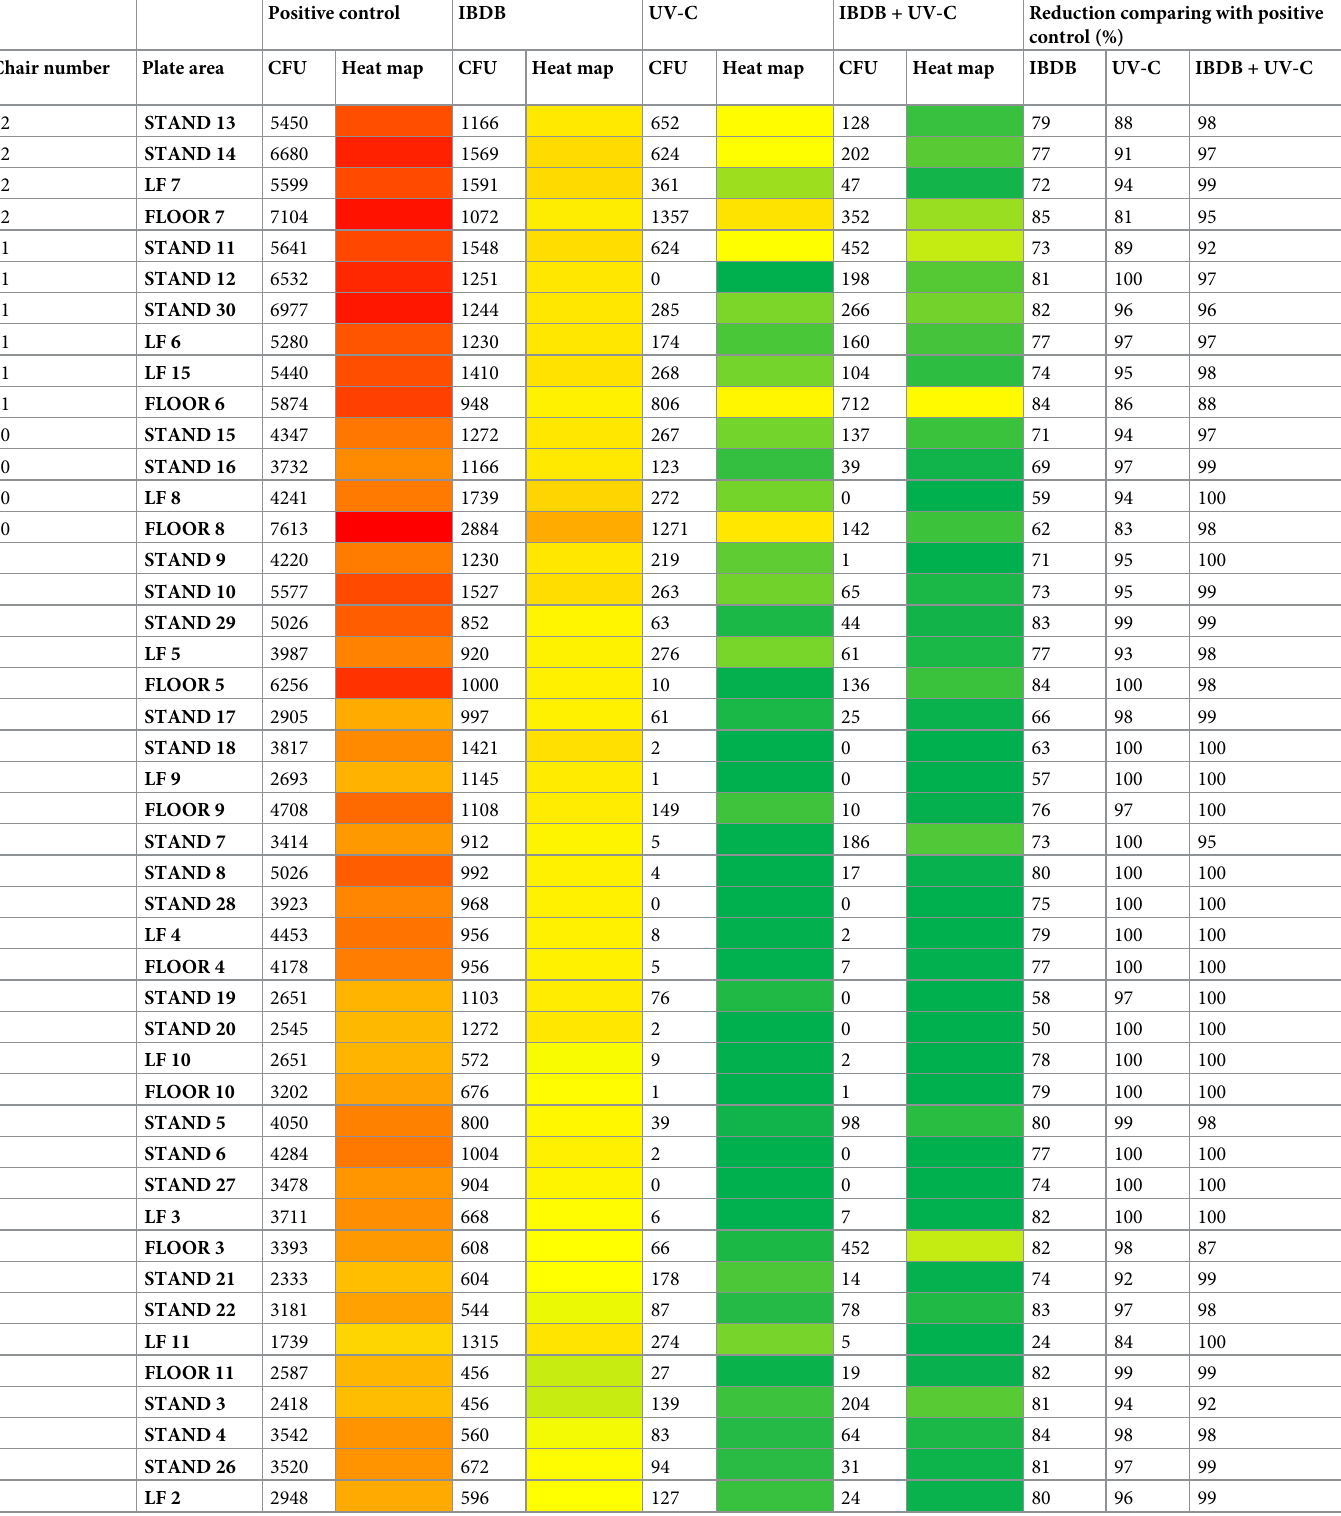
Table 1. CFU counts and a heat map of the dispersion of the counts of the plates on the different surfaces and groups